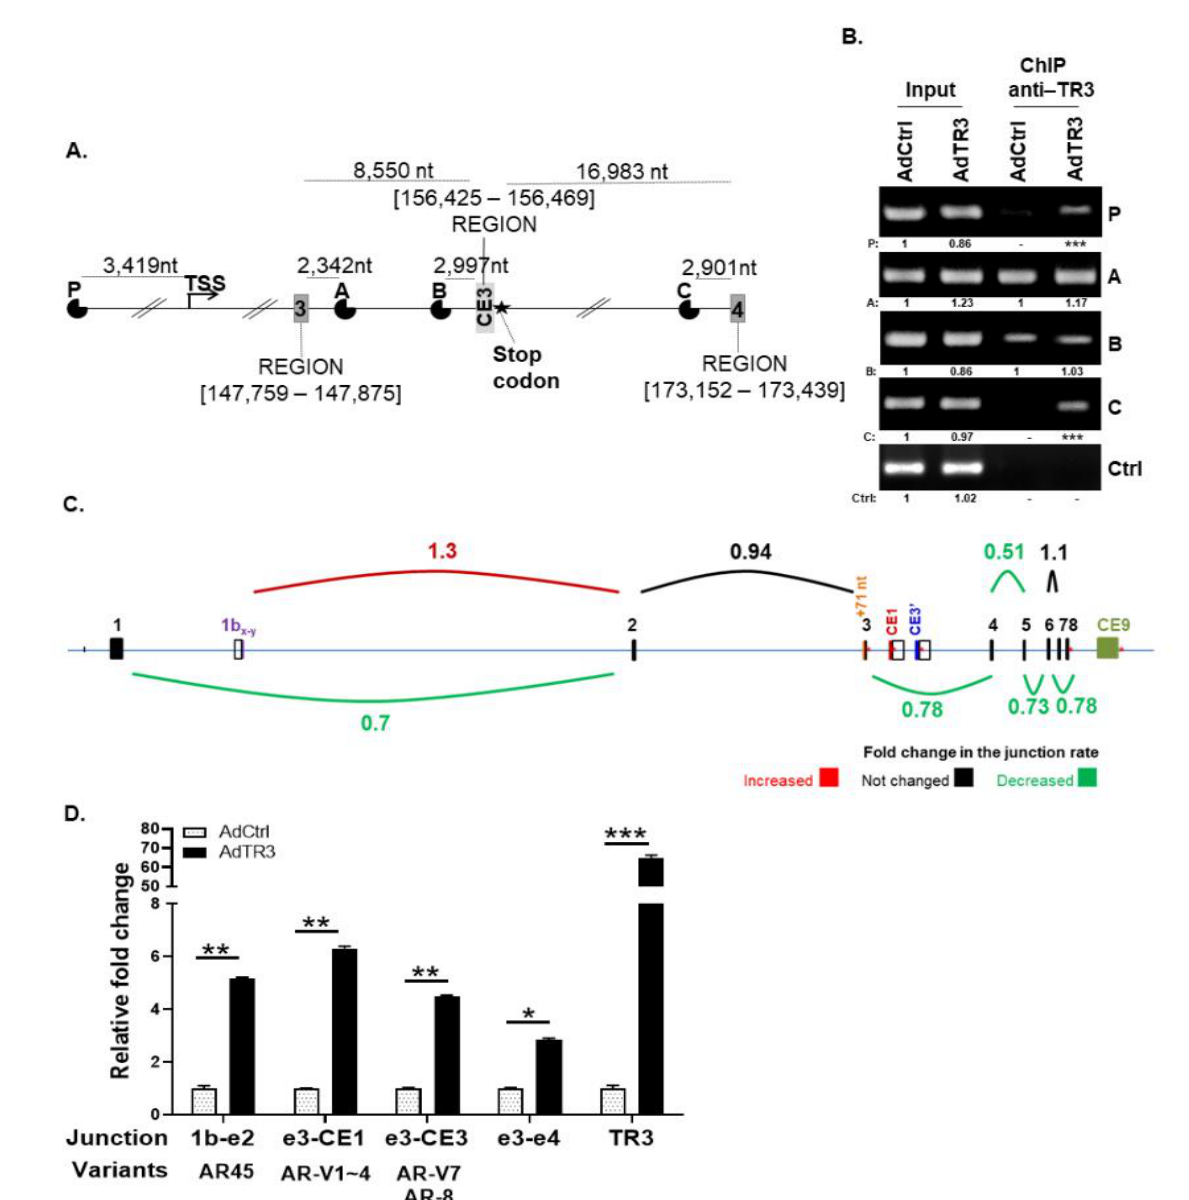
Figure 2. TR3 regulates the expression of AR splicing variants, altering splice junction rates between exons. ( A , B ) TR3 binds to the promoter and intron regions of AR gene. Schematic presentation of putative TR3 binding sites (P, A, B, and C) in AR gene ( A ). Recruitment of TR3 protein to putative TR3 binding sites within the promoter and intron regions of the AR gene was determined via